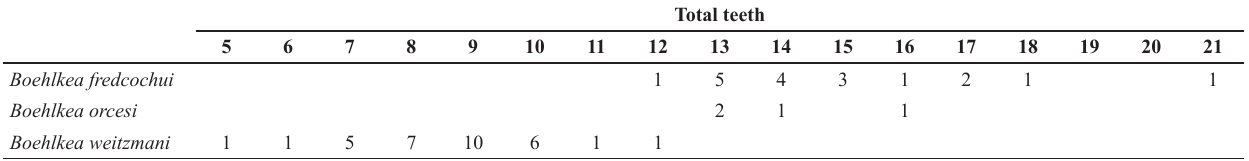
Fig. 6. a. Paratype of Boehlkea fredcochui , ANSP 111668, 31.8 mm SL, upper Amazon from surroundings of Leticia, Colombia; b. Holotype of Boehlkea orcesi , USNM 164064, 47.4 mm SL, río Macuma, northern tributary of upper río Morona, upper Amazon, Santiago-Zamora, Ecuador. Tab. 2. Frequency distribution of maxillary teeth of Boehlkea species. Data of B. fredcochui and B. orcesi were obtained from Géry (1966), Böhlke (1958), and from comparative material